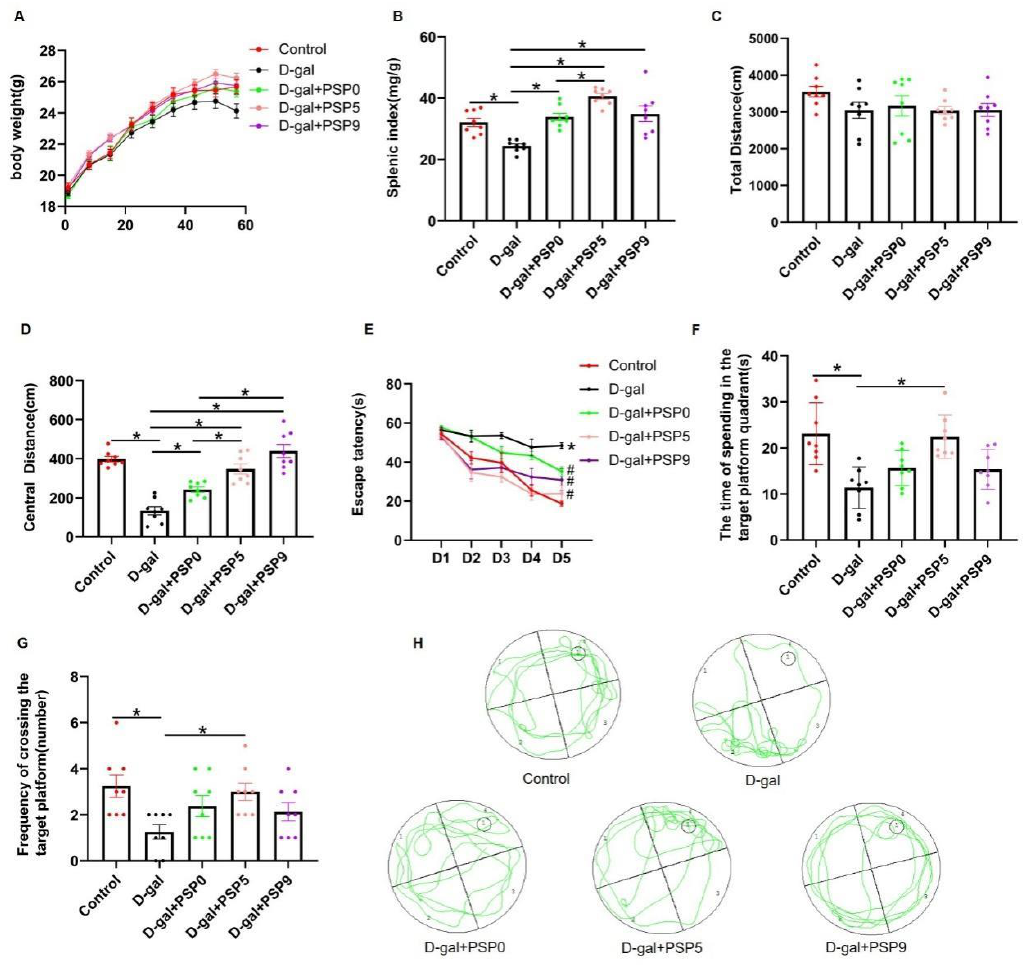
Figure 3. Steamed PSPs ameliorate the decrease of splenic index and behavioral defects in D-gal- induced mice. Steamed PSPs increased ( A ) body weight and ( B ) spleen index in D-gal-injured mice. ( C , D ) Total distance and central distance traveled in the OFT ( n = 8 per group). ( E ) Escape latency, ( F ) time spent in the target platform quadrant, and ( G ) frequency of crossing the target platform in the MWM; ( H ) traces of the MWM. Data are expressed as means ± SEM ( n = 8 per group). * p < 0.05 vs. Control, # p < 0.05 vs. D-gal.